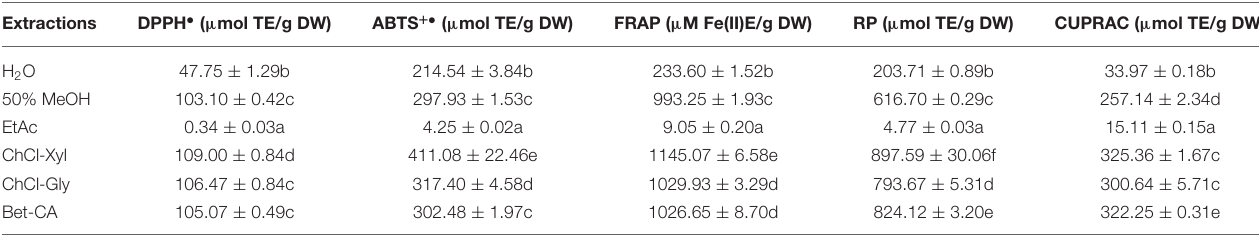
TABLE 4 | Antioxidant activities of the CIOPs extracts obtained by various solvents. Vehicle experiments of the corresponding solvents have been carried out.